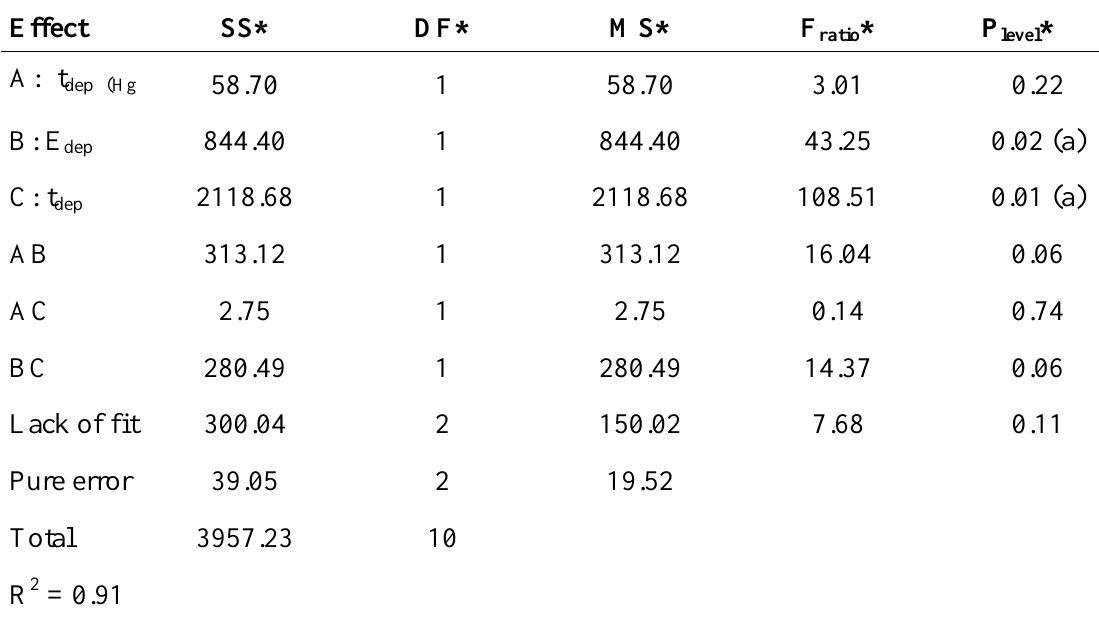
Table 1. ANOVA with the data of the 2 3 factorial design for optimization of experimental variables in Sb (III) determination by DPASV.